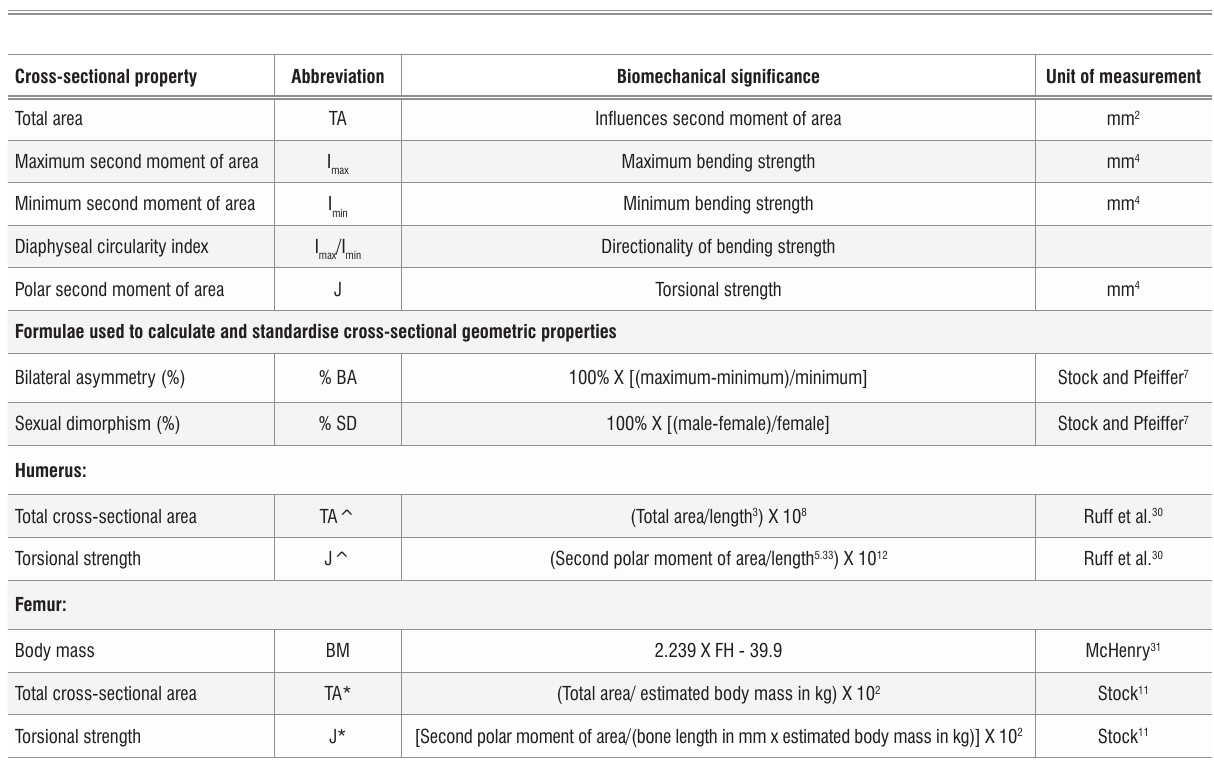
Table 2: Definitions and formulae for cross-sectional geometric properties and standardisation protocols used in this study